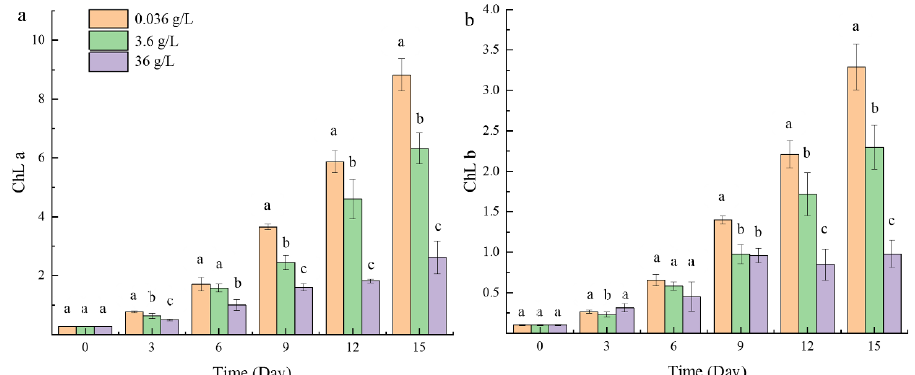
Figure 3. Effects of three concentrations of CaCl 2 on the Chlorophyll content of P. kessleri FACHB-3316: ( a ) chlorophyll a; ( b ) chlorophyll b (The letters a, b and c indicate the significance of the dif- ference).